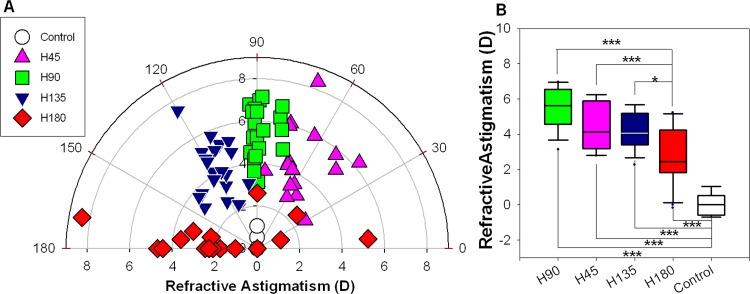
Refractive astigmatism induced by optically imposed astigmatism of four different orientations.(A) Distributions of inter-ocular differences in refractive astigmatism (treated/right eye—fellow/left eye) after one week of cylindrical lens treatment (P5-P12) for the four treatment groups (+4.00DS/-8.00DC, n = 20 in each group) with negative cylindrical axis oriented at one of the four directions (45, 90, 135, or 180), as well as the age-matched controls (n = 8). The effects of the axis of cylindrical lens are represented by different coloured symbols as shown in the legend. For example, in chicks treated with H90, the +4.00DC and -4.00DC were oriented vertically and horizontally respectively; to compensate for this astigmatic error, the eyes should develop negative cylindrical axis at 90. As shown in A, the cylindrical lenses of different axes induced compensatory astigmatism in the four treatment groups. (B) The box plots of refractive astigmatism include the values of median (line inside the box), maximum (upper whisker), minimum (lower whisker), upper (upper border of box) and lower quartiles (lower border of box) for the controls and treatment groups at P12. The levels of significant differences in the magnitudes of refractive astigmatism across the treatment groups (lines above the boxes), or between treatment and controls (lines below the boxes), are indicated by asterisk: * p≤0.05, *** p≤0.001 (Tukey’s post hoc tests).